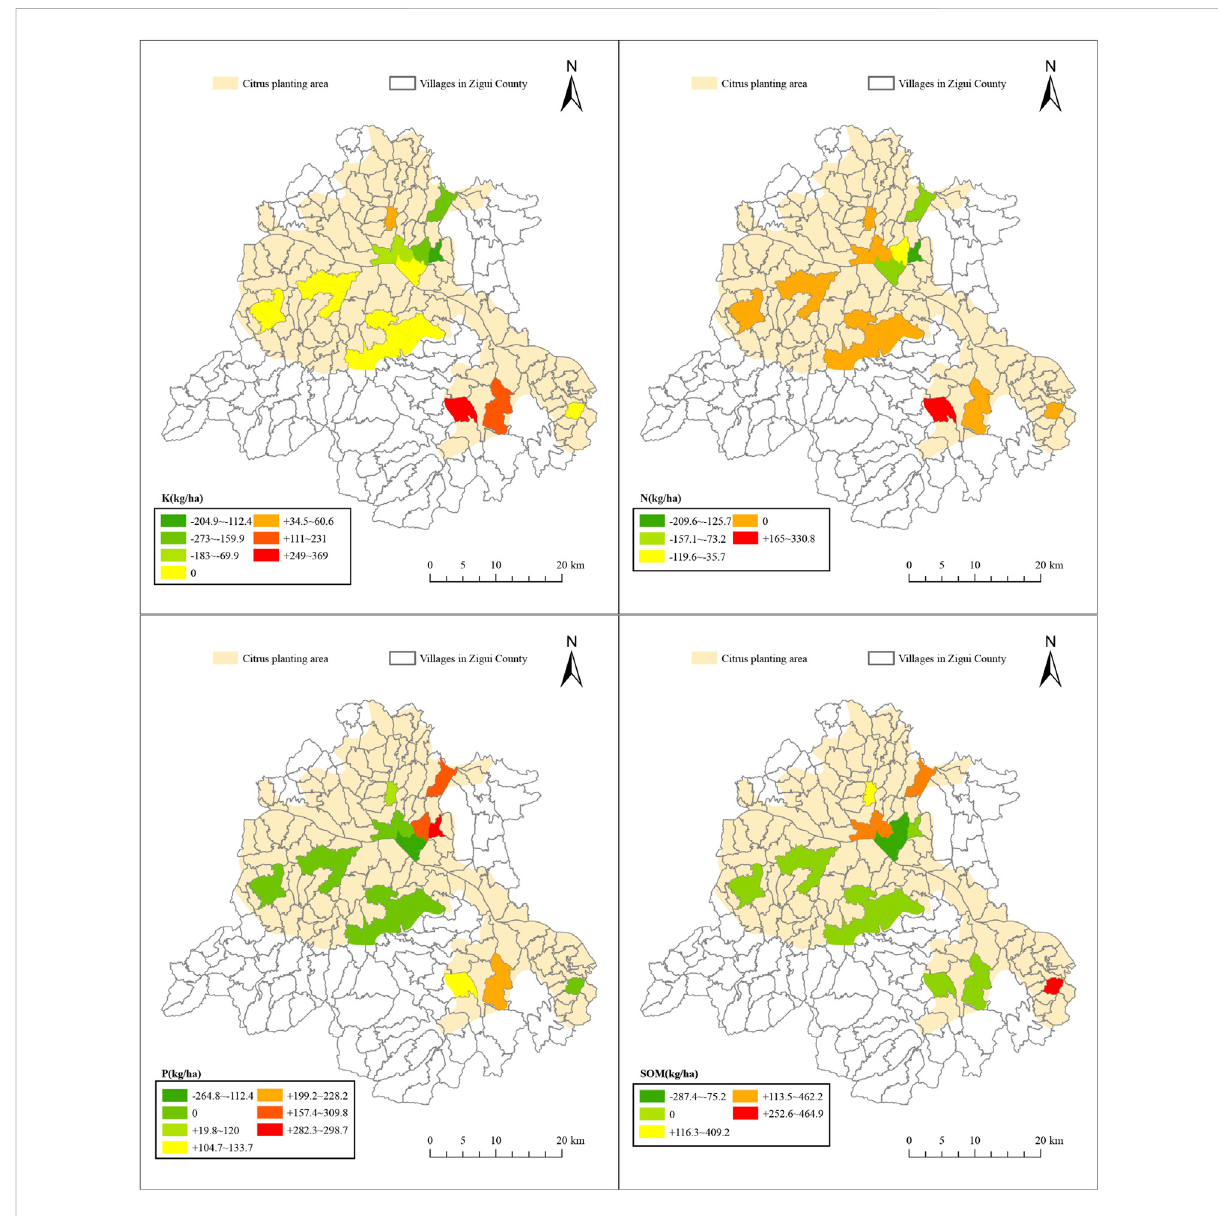
FIGURE 5 Optimized fertilization regimes for different towns. Note: + indicates increases; - indicates